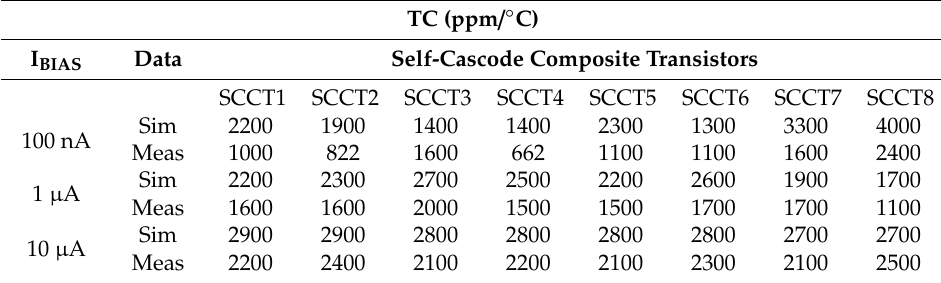
Table 1. Measured temperature coe ffi cients (TCs) of the SCCTs.